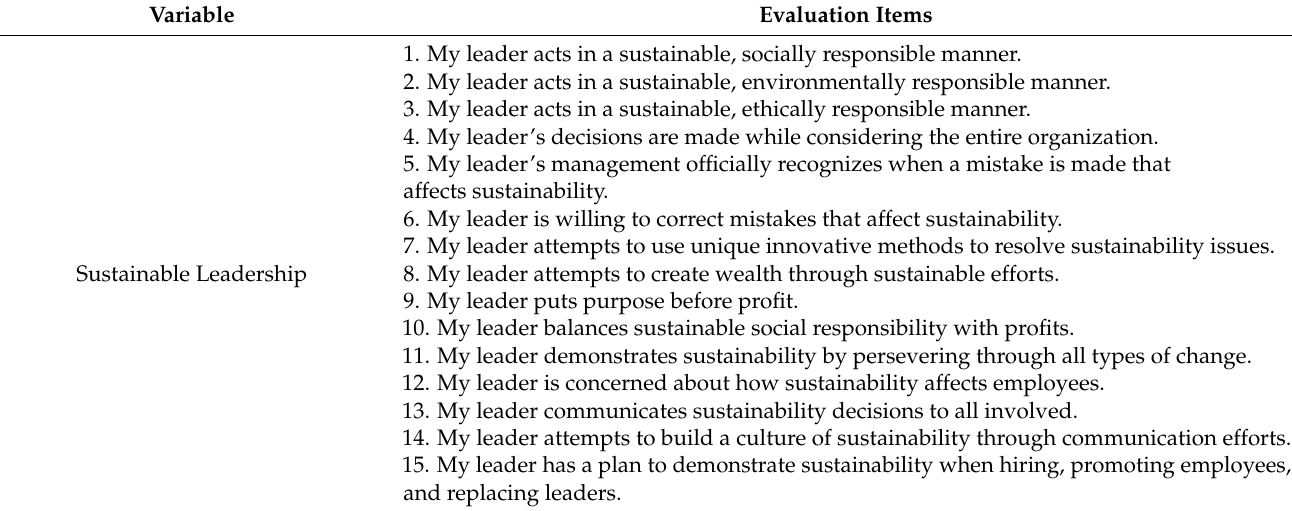
Table A1. The evaluation